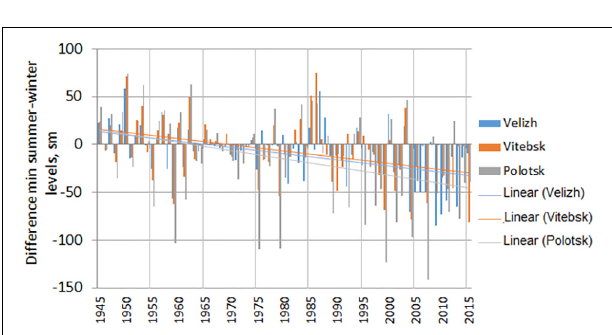
FIGURE 11 | The differences between minimum summer and minimum winter level and their linear trends.